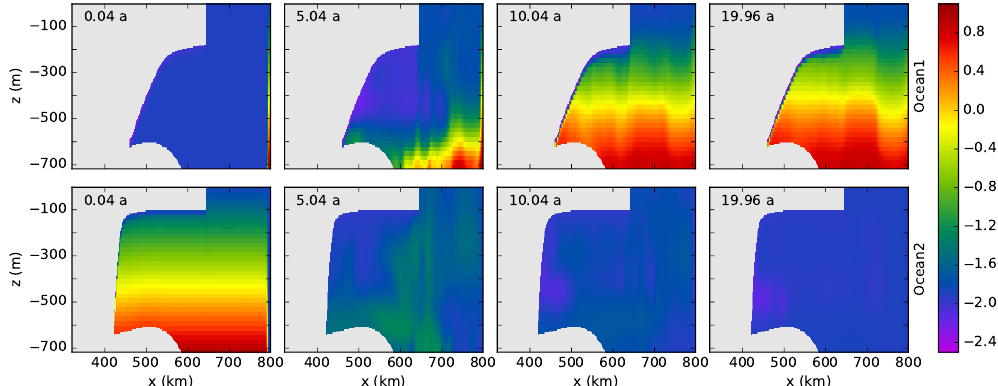
Figure 10. Example results from POP2x as in Fig. 8 but for Ocean1 (top) and Ocean2 (bottom) simulations each lasting 20 years. In both experiments, the ice draft is held fixed in time. Ocean1 is initialized with COLD profiles and restored to WARM profiles. Melt rates are initially low and the overturning strength is initially relatively weak, so that warm, deep water takes several years to reach the back of the sub-ice-shelf cavity, at which point melting increases by several orders of magnitude, reaching a quasi-steady state for approximately the second half of the experiment. Ocean2 is initialized with WARM profiles and restored to COLD profiles, leading to a melt rate that decays by several orders of magnitude over the duration of the simulation. Ocean2 does not reach a quasi-steady state within its 20-year